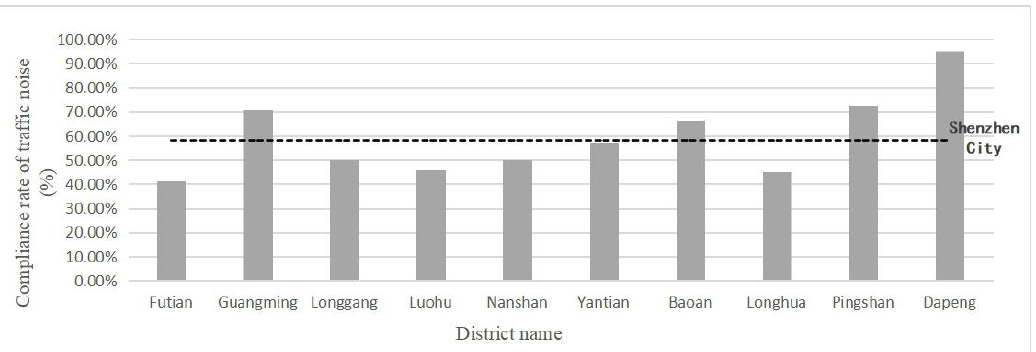
Figure 5. Situation of traffic noise up to the standard in Shenzhen and each district.